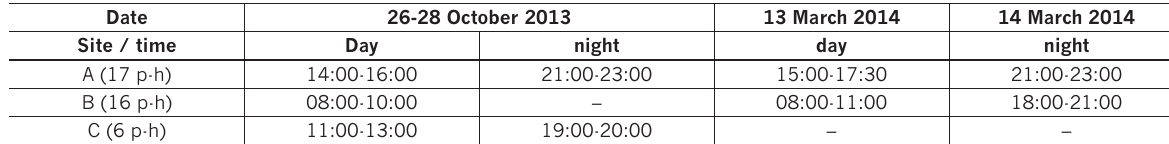
accession numbers). Muscle samples of some toads